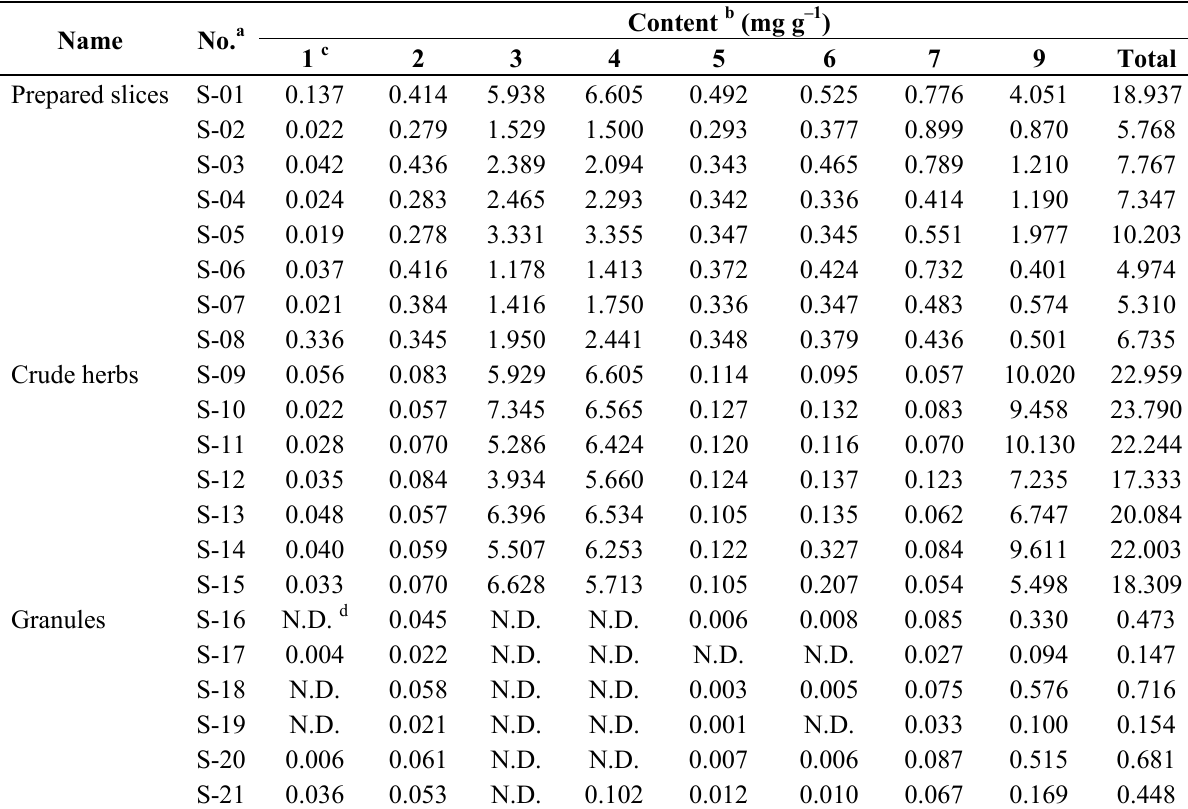
Table 3. The contents (mg g –1 ) of eight targets in 21 commercial samples ( n =